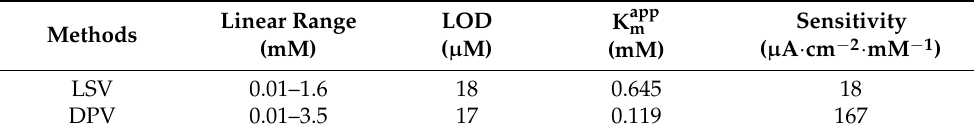
Table 2. Comparison of Glu-sensing performance of NF-GLA/MWCNTs-BSA-HFs-GOD/GCE in 50 mM phosphate-buffered solution using different